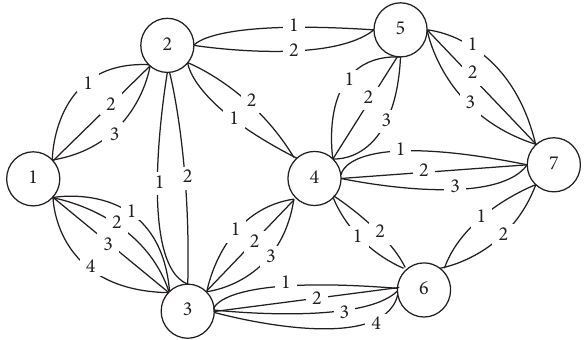
Figure 1: Multigraph of